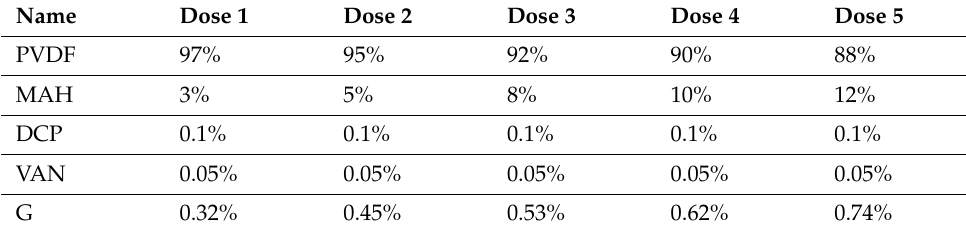
Table 3. A list of the specific compositions used in blending with different MAH contents.